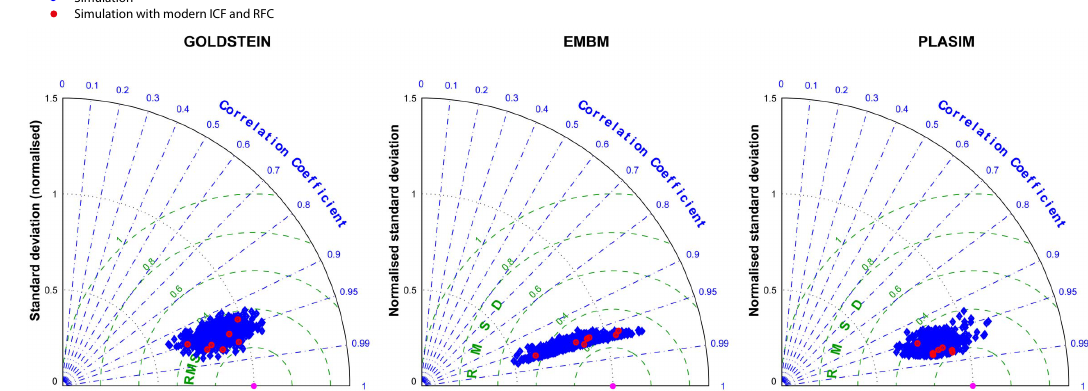
Figure 3. Taylor diagrams showing a comparison between model runs with climatology: GOLDSTEIN SST (left), EMBM SAT (middle) and PLASIM SAT (right). The magenta dots represent reanalysis taken from Locarnini climatology (1900–2005) (Locarnini et al., 2006) (left), NCEP-DOE reanalysis 2 annual mean SAT (1979–2013) at 1000mb (Kanamitsu et al., 2002) (middle) and NCEP-DOE reanalysis 2 annual mean SAT (1979–2013) at 2m (Kanamitsu et al., 2002) (right). The points highlighted in red represent runs with ICF ∈ { 0 , 1 , 2 , 3 , 4 } and 340ppm < RFC <